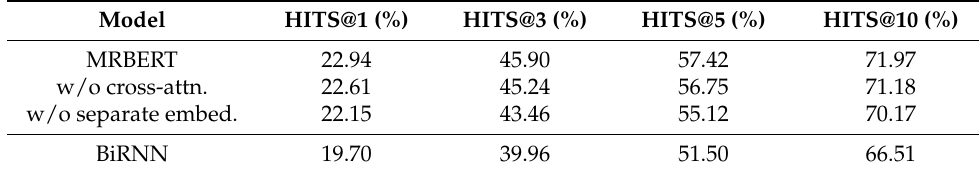
Table 6. Ablation experimental results of Seq2Seq generation